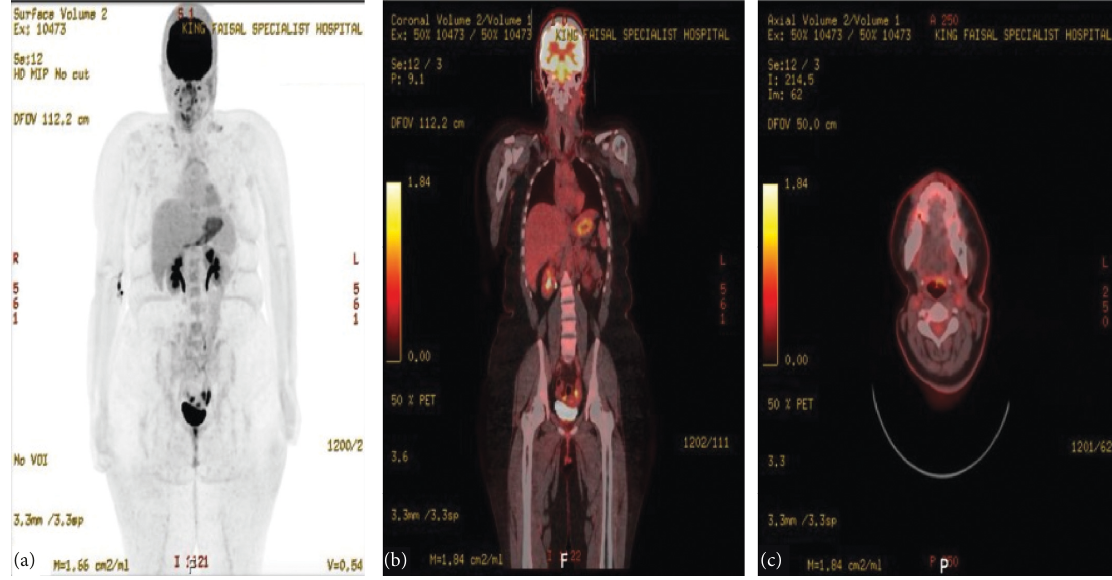
Figure 10: The PET scan in January 2022. The study ((a)–(c)) was compared with previous studies. The upper and lower cervical lymph nodes are showing mild FDG avidity with SUVmax of 1.8. However, there is no change morphologically, and it is most likely reactive. On the other hand, physiological radiotracer distribution is seen in the brain and there are no new suspicious FDG-avid lesions seen otherwise. Table 1: All cases present in the literature reporting bilateral metachronous ACC of the parotid gland.